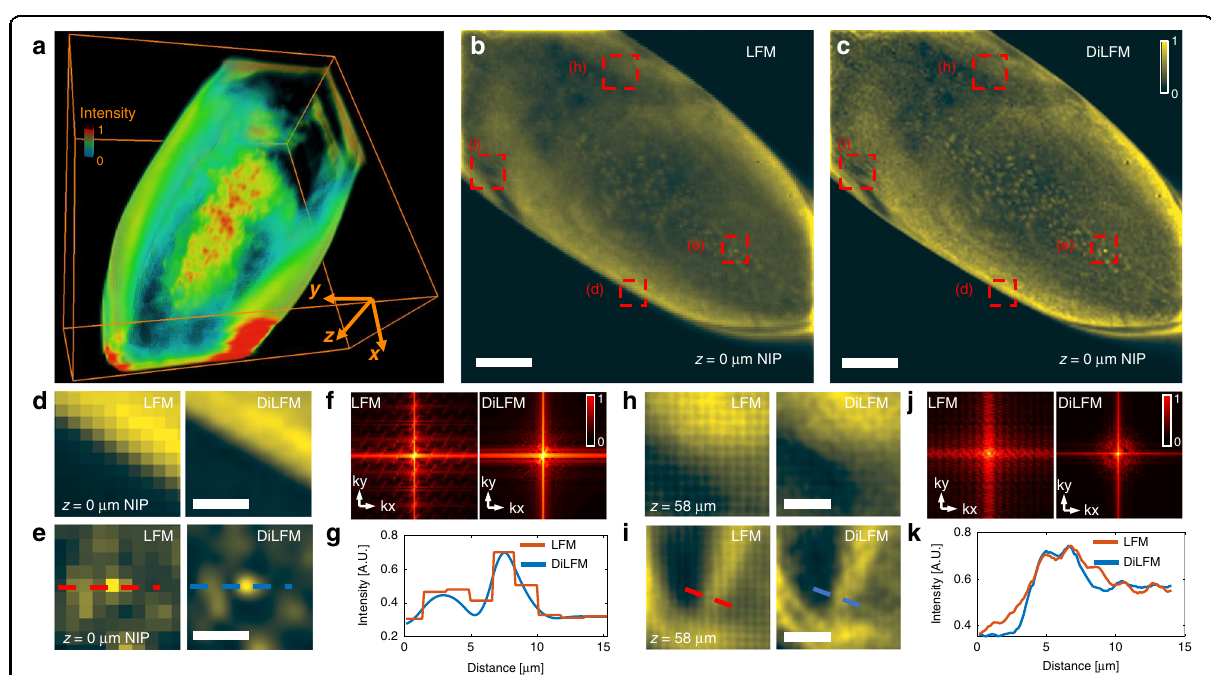
Fig. 2 DiLFM suppresses artifacts and increases the contrast in reconstructing the Drosophila embryo. a Reconstructed Drosophila embryo in a depth range of 164 µm. b , c Reconstructed z = 0 µm layer (NIP) by RL and DiLFM, respectively. d , e Zoom-in area marked by the red dashed boxes in ( b ) at z = 0 µm (NIP) by RL (left) and DiLFM (right). f Fourier transform of ( d ) in the log scale. g Intensity pro fi le along the dashed line in ( e ) by RL (blue) and DiLFM (red). h , i Zoom-in areas marked by red dashed boxes in ( b ) at z = 58 µm by RL (left) and DiLFM (right). j Fourier transform of ( h ) in the log scale. k Intensity pro fi les along the dashed line in ( i ) by RL (red) and DiLFM (blue). Scale bars in ( b ) and ( c ) are 50 µm, in ( d ), ( e ), ( h ), ( i )